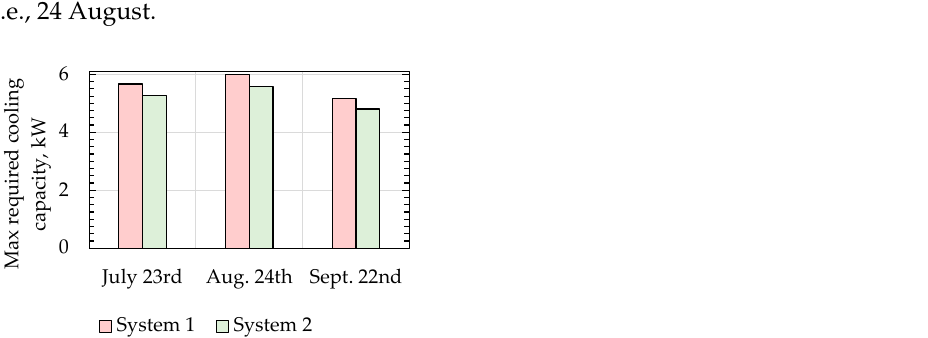
Table 6. Determination of the supply airflow.